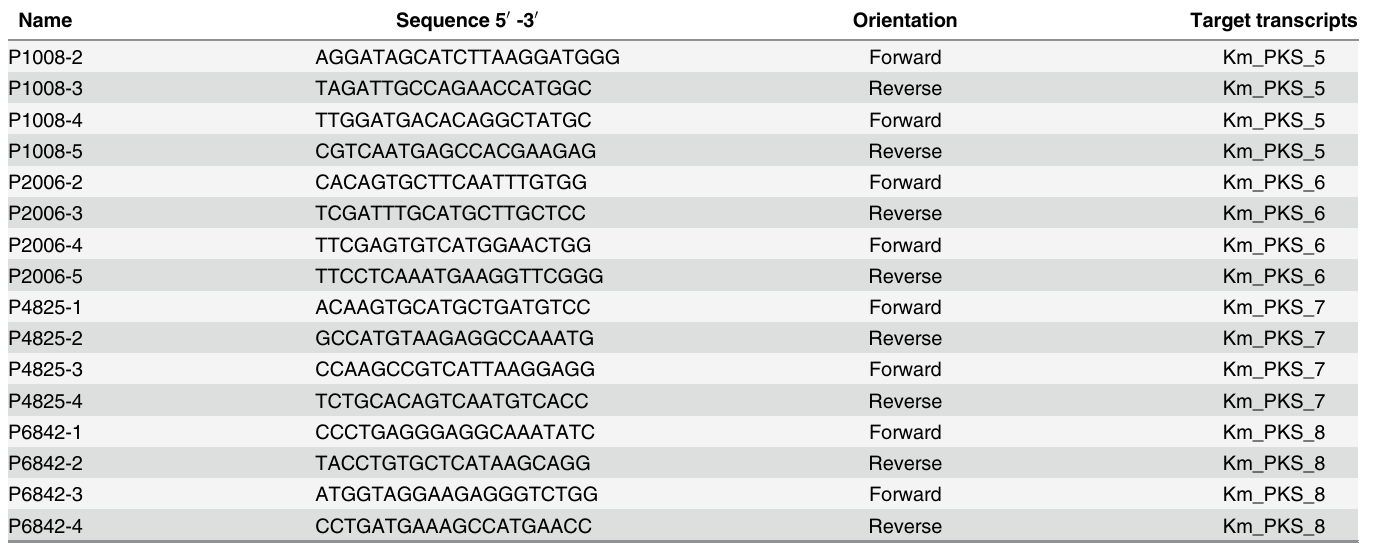
Table 1. Primers used in the RT-PCR